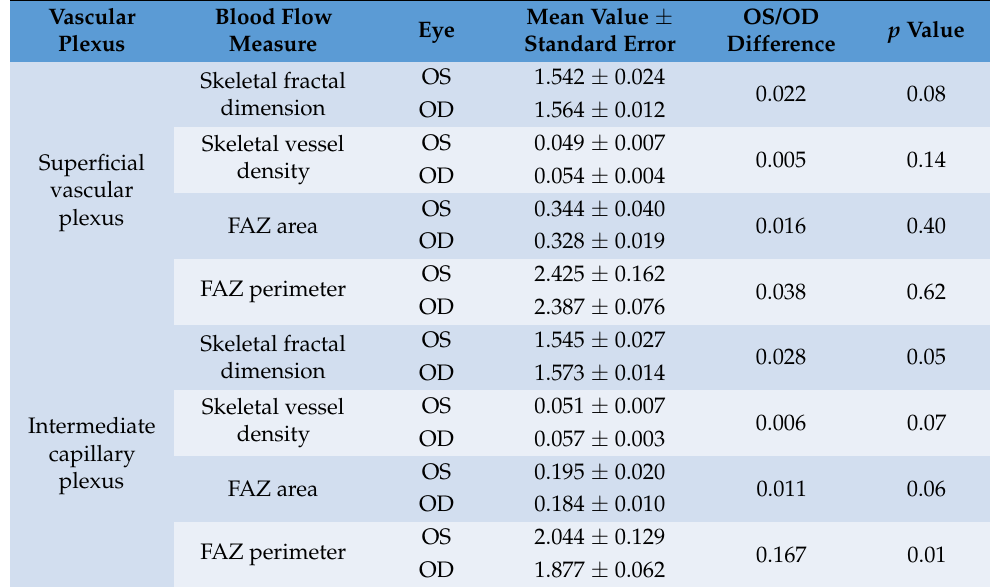
Table 4. Blood flow measures and inter-eye differences. FAZ: foveal avascular zone; OS: left eye; OD: right eye.